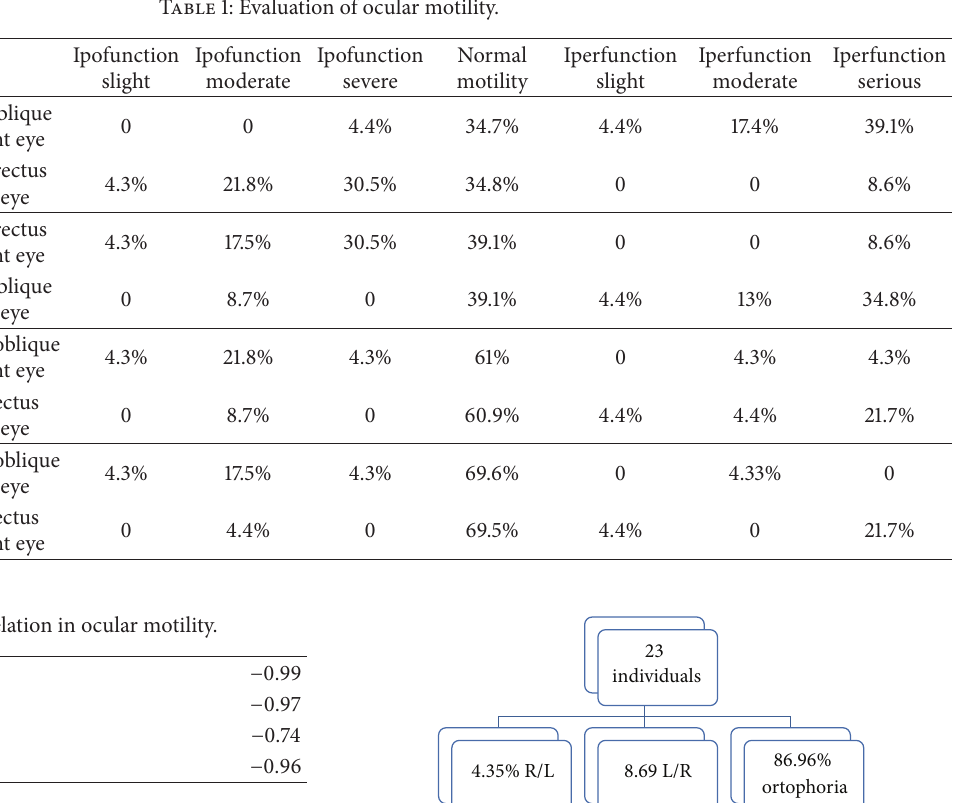
Table 1: Evaluation of ocular motility.